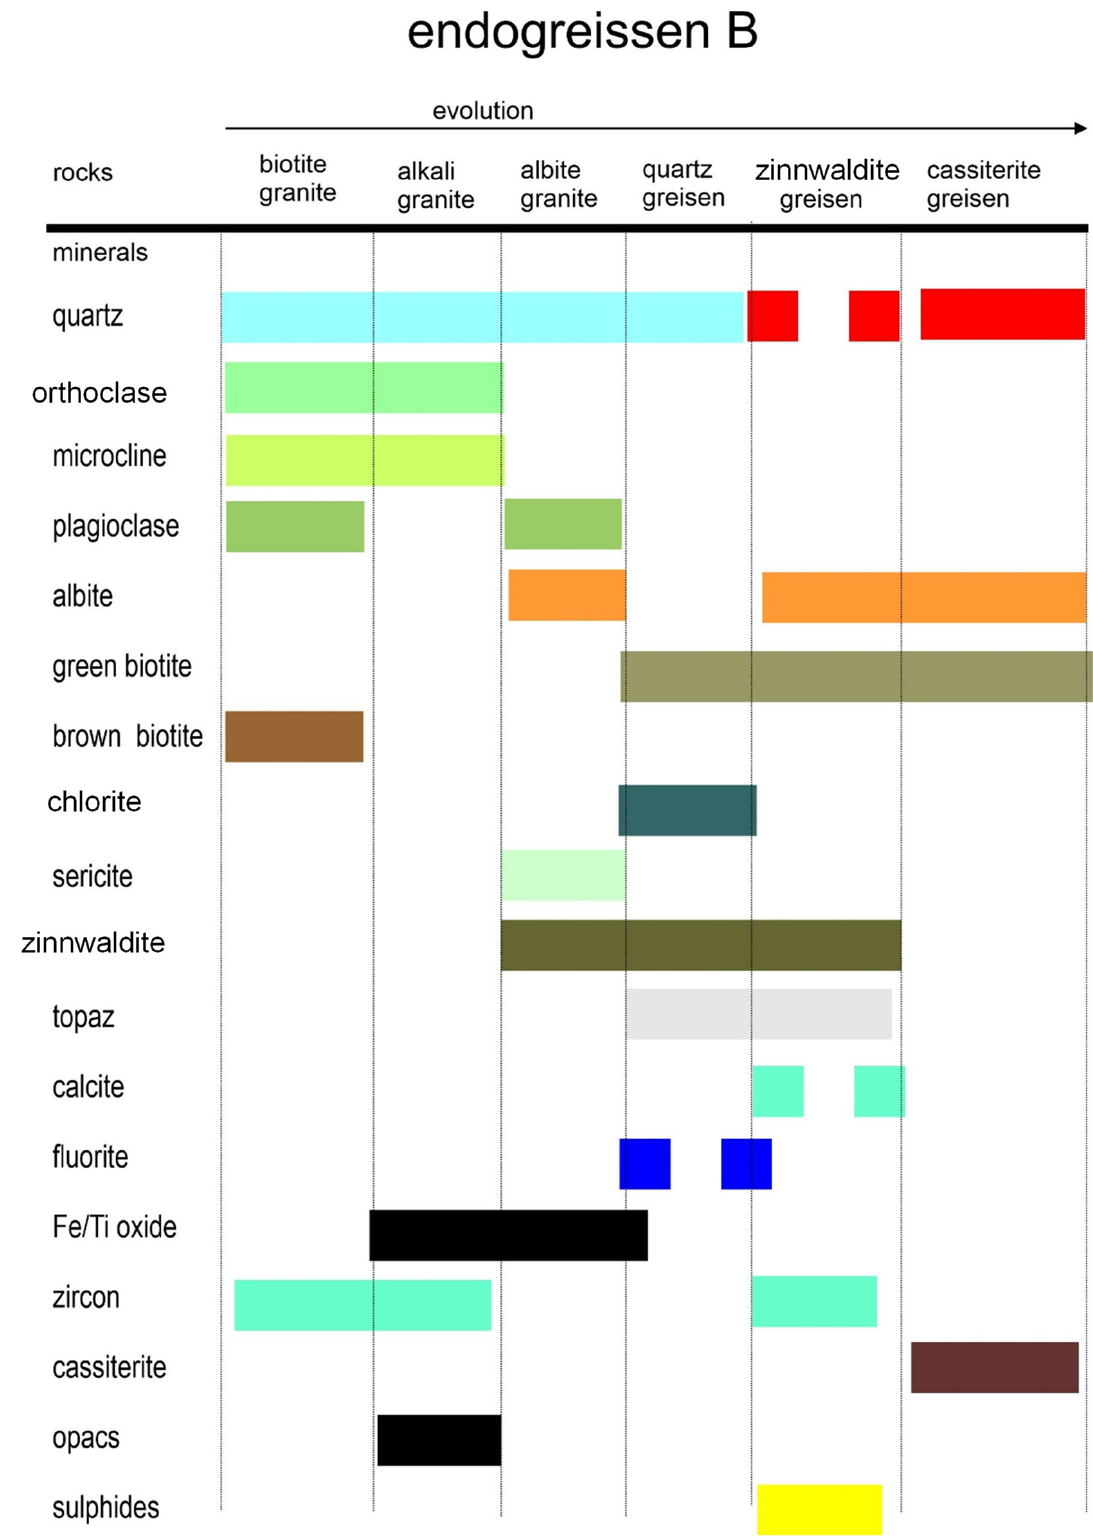
Figure 13. Mineral paragenesis was obtained by petrographic analysis of samples related to En- dogreisen B. The petrographic studies indicate the magmatic-hydrothermal fluids evolved from biotite-granite to alkali-granite to topaz-granite, reaching the greisens phase. At the final evolution stage, the topaz-mica greisens are formed, composed of a hypidiomorphic matrix of topaz, zinnwaldite, and plagioclase and phenocrysts of topaz and quartz.